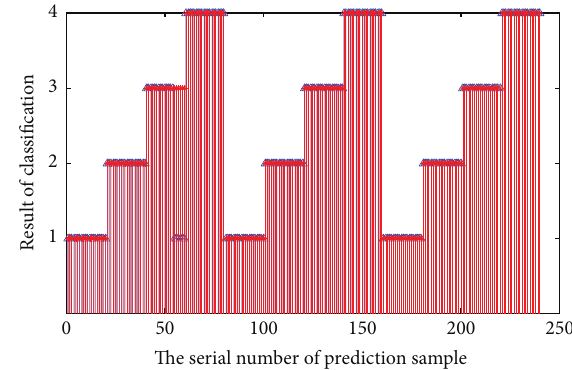
Figure 16: The classification result of the second cross-validation group.